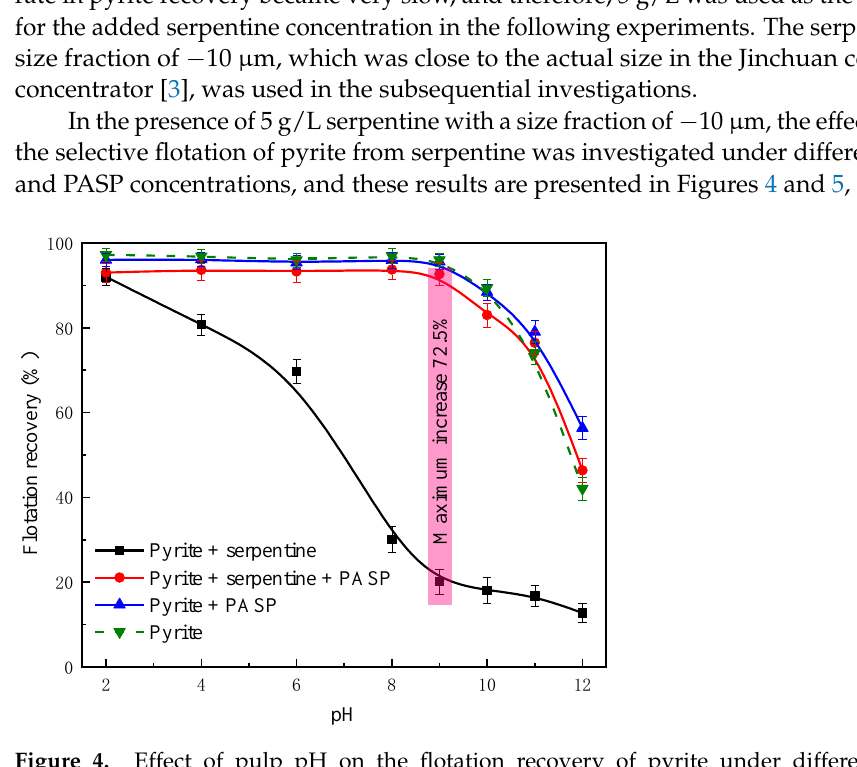
Figure 4. Effect of pulp pH on the flotation recovery of pyrite under different conditions ([PASP] = 15 mg/L, [serpentine ( − 10 µm)] = 5 g/L).